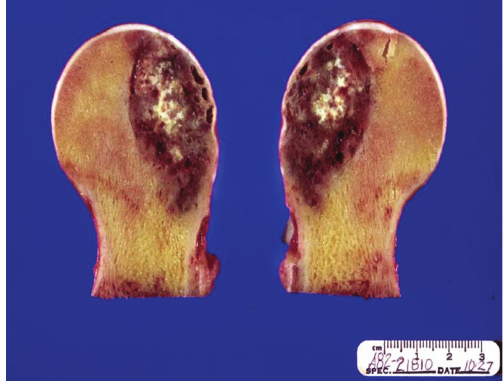
Figure 15: Gross finding of clear cell chondrosarcoma in the proximal